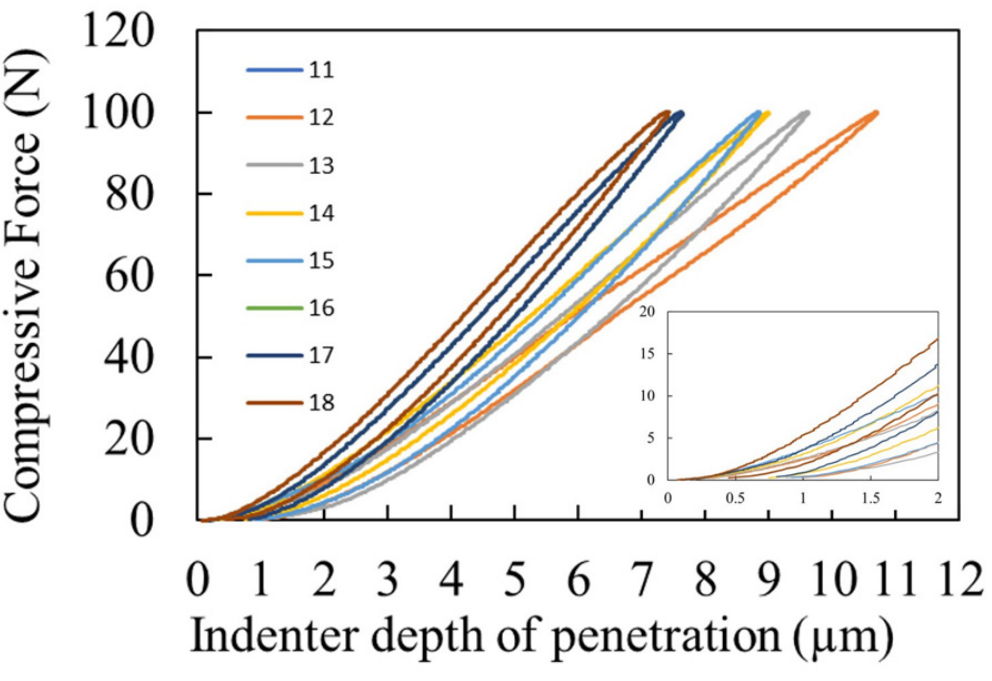
Figure 10. Indentation curves of compressive force versus indenter depth generated with the Zwick indentation system for the SiC-B 4 C-Si composites.